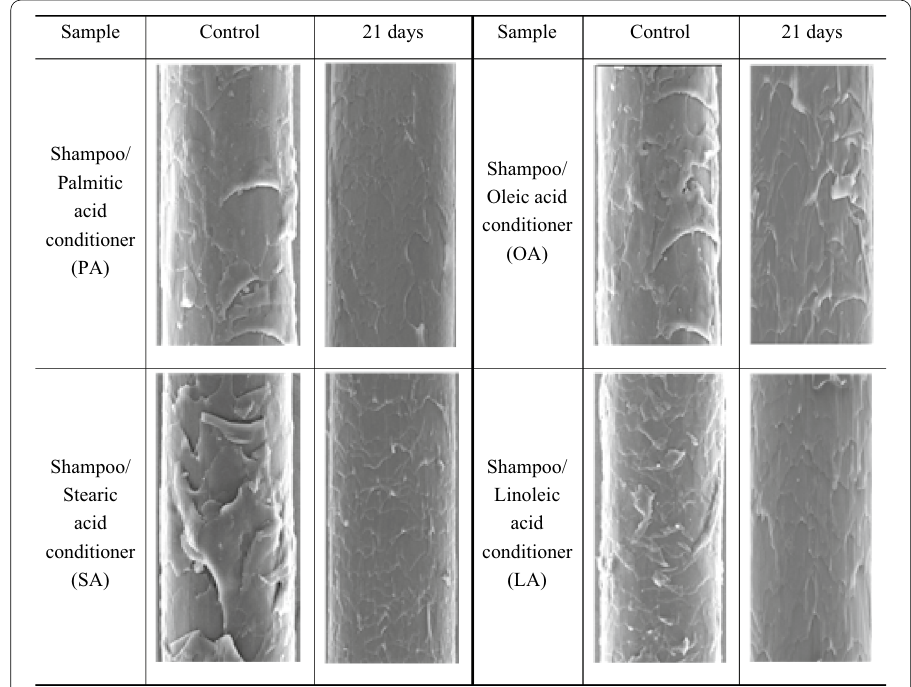
Fig. 4 SEM images of bleached hair treated with hair conditioner containing four types of fatty